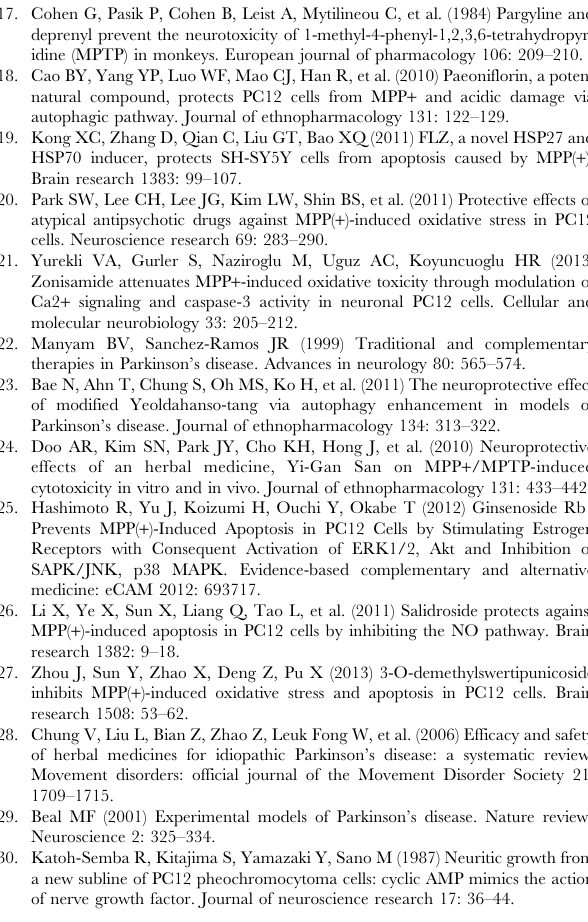
Figure S1 The correlation between contents of Glycyr- rhiza and neuroprotective activity in herbal medicines. (TIF) Figure S2 Toxicity of EtOAc extract of Glycyrrhiza . NGF-differentiated PC12D cells were treated with various concentrations of EtOAc extract of Glycyrrhiza for 48 h. Cell viability was evaluated by trypan blue dye exclusion assay. (TIF) Figure S3 Licopyranocoumarin and glycyrurol prefer- entially showed cytoprotective effects in neuronal cells. HeLa cells or NGF-differentiated PC12D cells were treated with various concentrations of licopyranocoumarin (LPC) or glycyrurol (GCR) in the presence of 0.3 m M Rotenone for 48 h. Cell viability was evaluated by trypan blue dye exclusion